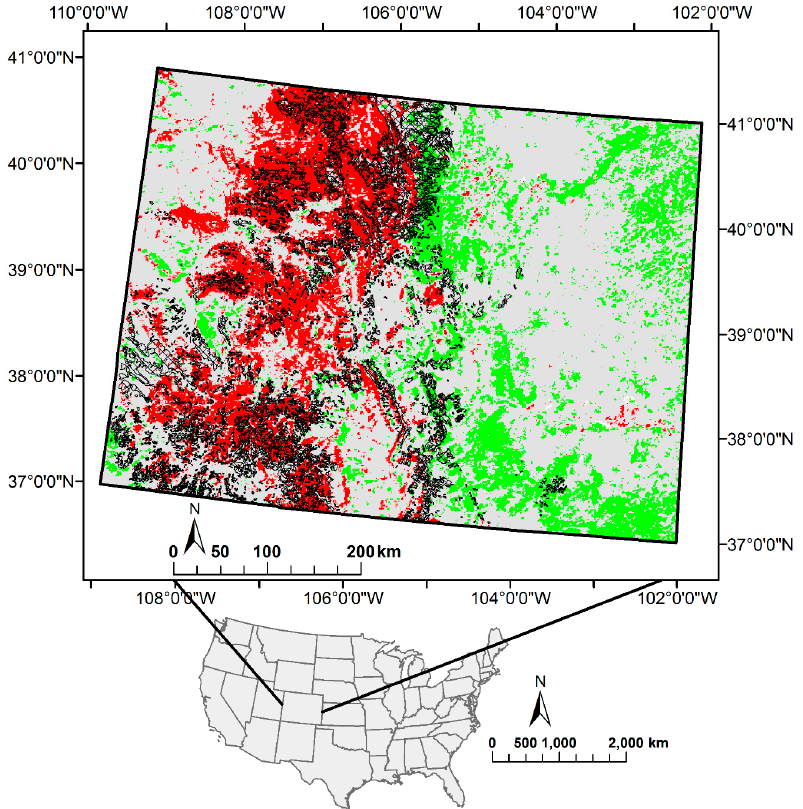
Figure 7. Progress of tree mortality from insect infestation and diseases in Colorado from 1994 to 2013 (black hatching). Green pixels indicate a significant increase in the NDVI over time (multivariate autoregression), and red pixels indicate significant decrease in NDVI over time (multivariate autoregression).